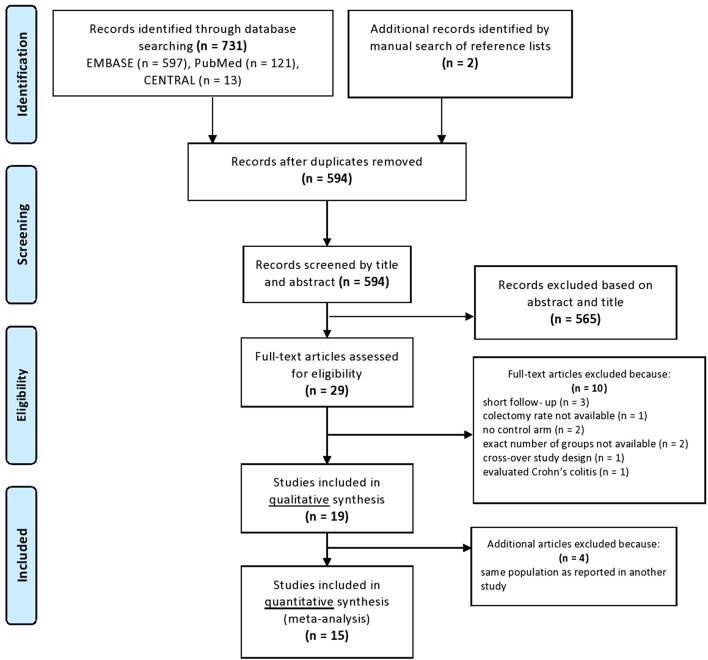
PRISMA flowchart.